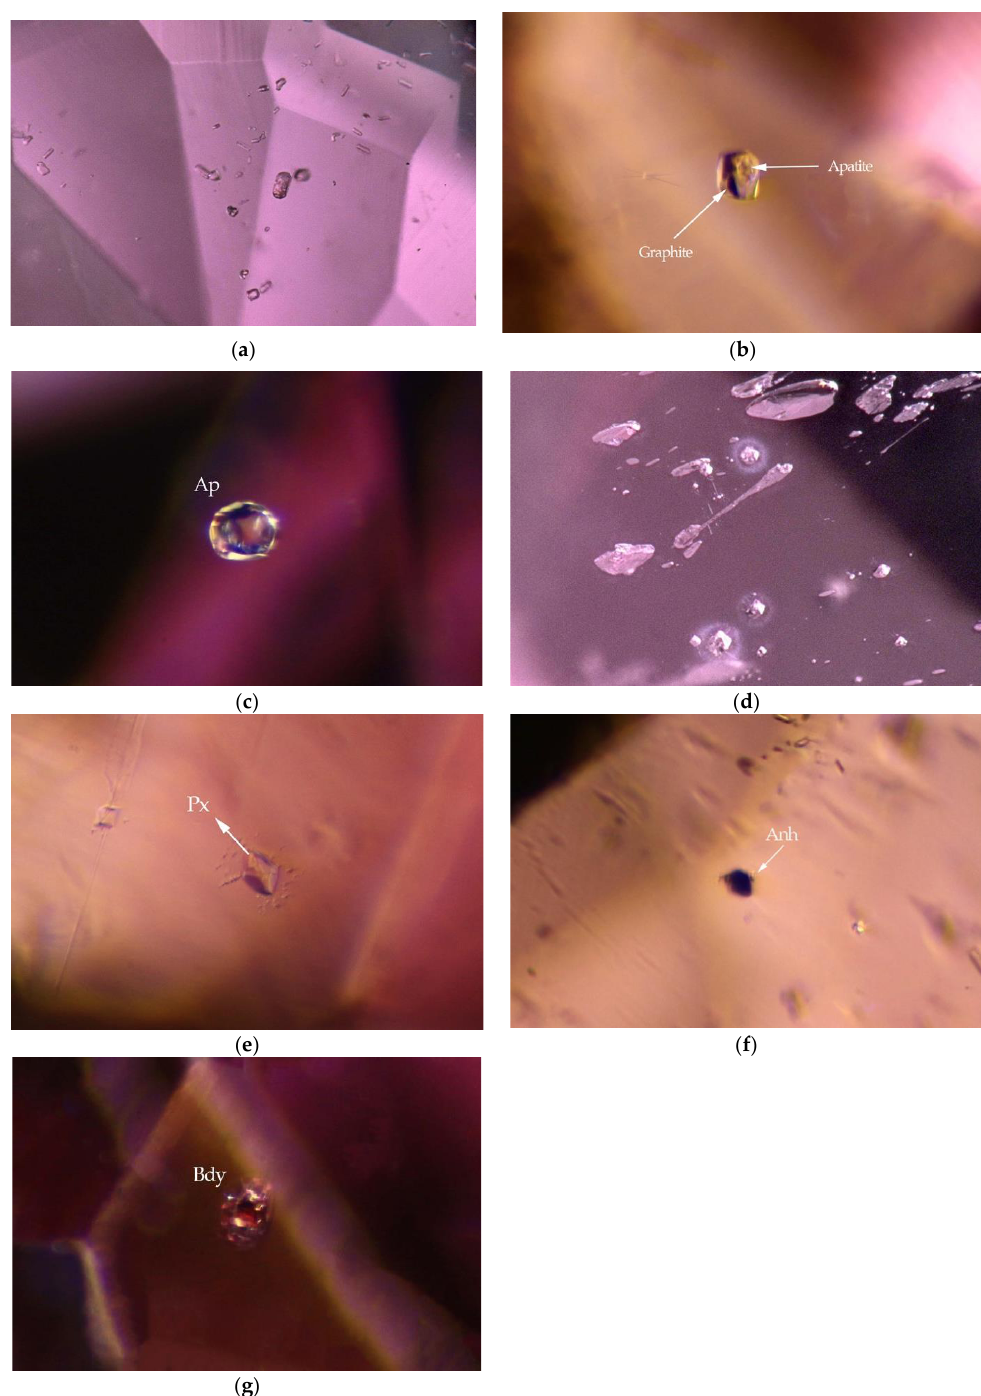
Figure 5. Inclusion scenes in purple spinels from Myanmar: ( a ) groups of euhedral apatite (Ap) (200×); ( b ) a single subhedral apatite (Ap) is associated with graphite (C) (80×); ( c ) isolated rounded apatite (80×); ( d ) several magnesite minerals included in negative crystals (200×); ( e ) a subhedral pyroxene (Px) was surrounded by some tiny colorless crystals (80×); ( f ) tiny colorless anhydrite (Anh) (80×); ( g ) reddish-brownish baddeleyite (Bdy) crystal associated with a tension crack (80×).